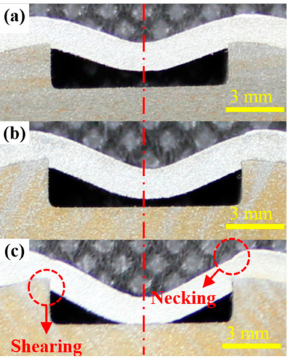
Figure 8. The deformation of the outer tube at position D ( a ) under 12 kJ, ( b ) 14 kJ, and ( c ) 16 kJ. The above test results showed that the strength of the joints with 14 and 16 kJ was higher than that of 12 kJ. It could be attributed to that the increase in discharging energy resulting in increasing deformation of the outer tube to fill the groove. Greater resistance could be provided during the torsion process. In addition, the deformation of the outer tube was different in the groove, so the specific deformation value was measured as shown in Figure 9. It could be found that the maximum deformation of different positions in the axial direction of the joint formed under various discharge energies was different. The deformation of the outer tube in the middle position of the connecting area (position D) was the biggest and gradually decreased from the middle to the two sides. The overall deformation near the inner tube side (region from position A to position D) was bigger than that away from the inner tube side (region from position D to position G) in the connected area. This was mainly due to the difference in the maximum deformation between position A and position G. There were two main reasons for this difference: one was the difference of the constraint imposed on between position A and G. It could be seen that position A was a free end while position G was not, which made it easier for position A to deform. Another was that position G was located on the edge of the coil, and the cross-positional area of the coil at the location of position G differed from that at the location of position A. The electromagnetic forces experienced by the outer tube wall at position G was lower than that at position A. As for the reason why position G was located on the edge of the coil, it was because without a mandrel supporting inside the outer tube. If the position of the connection region was moved toward the side away from the coil edge, the region closed to the connected area on the outer tube would be deformed by electromagnetic force, which would affect the joint